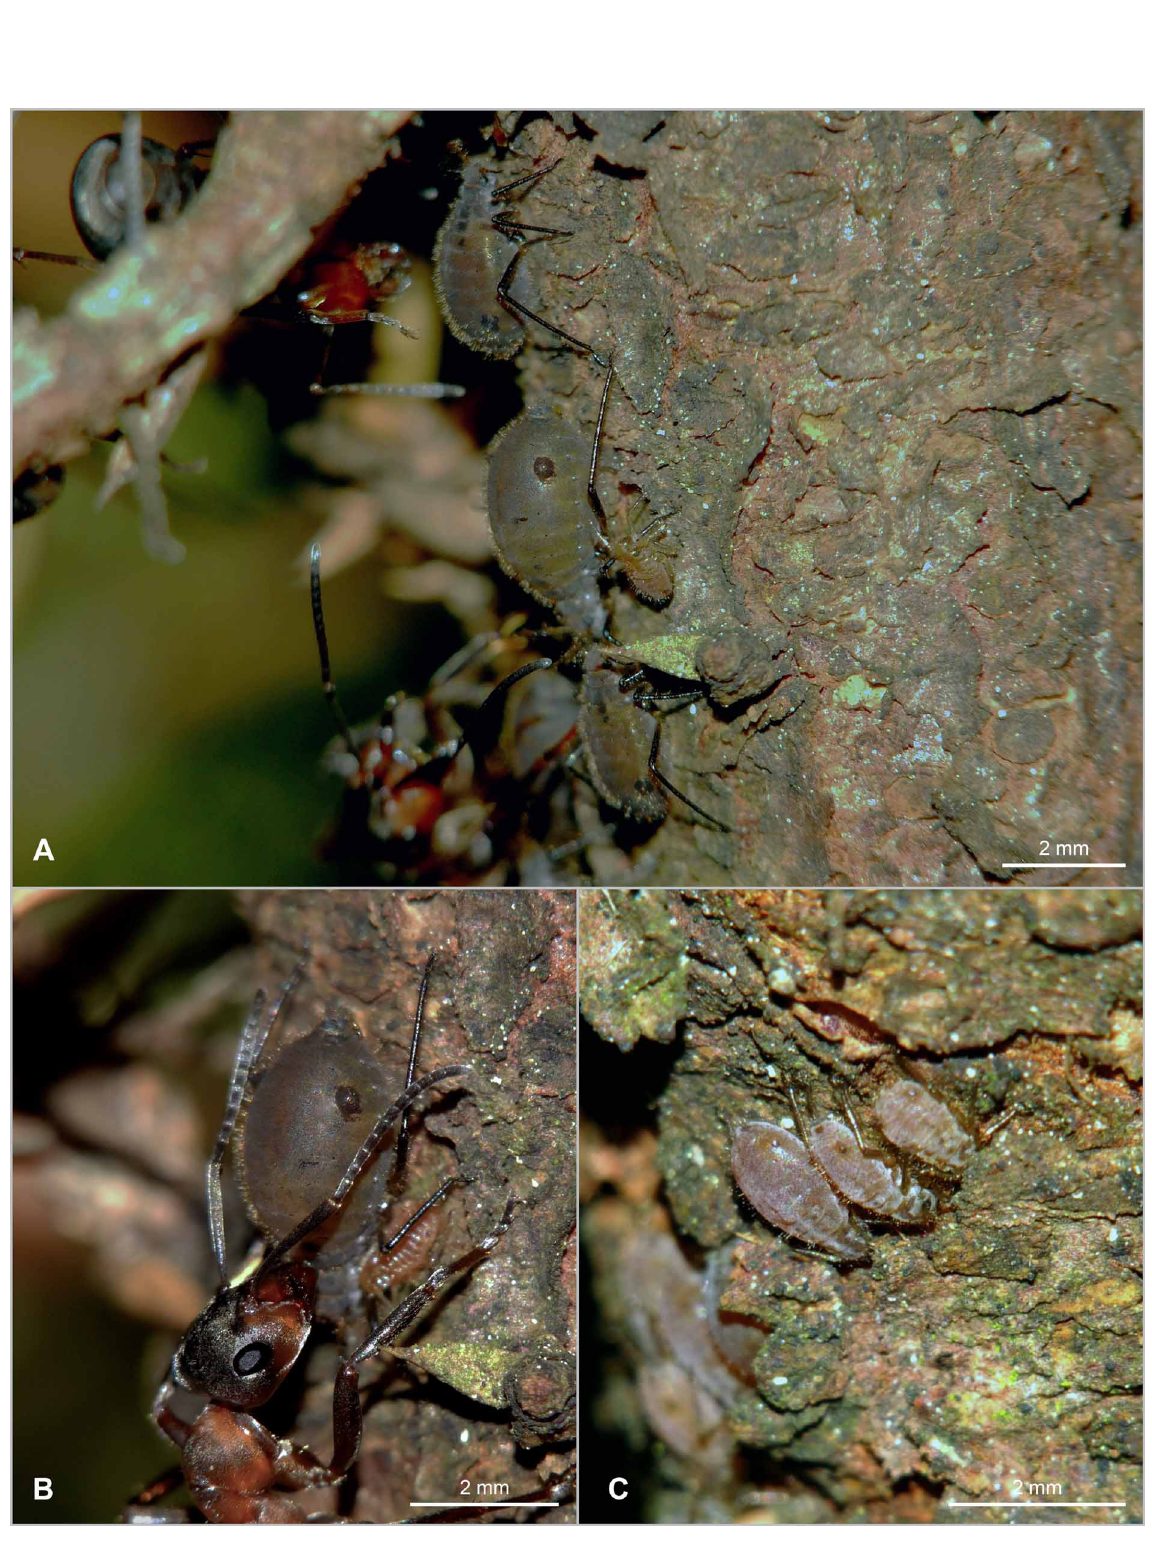
Fig. 112. Cinara (Cupressobium) smolandiae Danielsson & Carter, 1993. Colony in Gymnosporangium - induced wound on Juniperus communis , attended by Formica polyctena Förster,